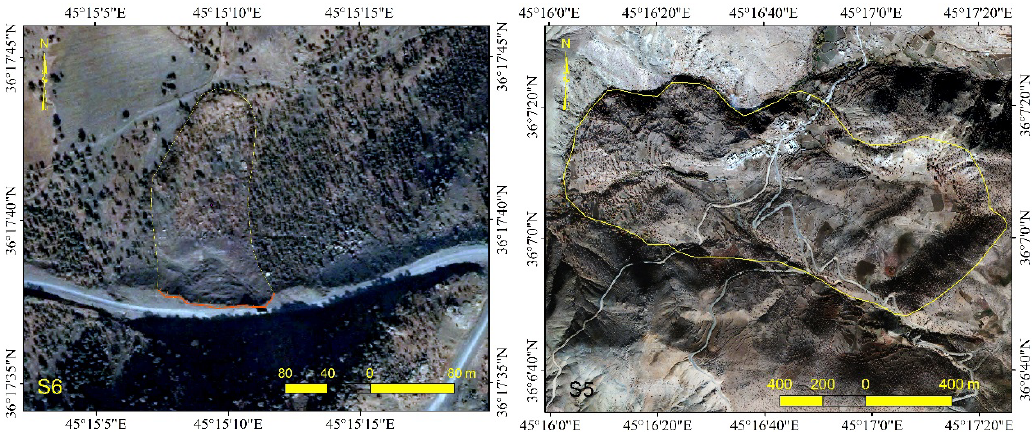
Figure 5. Red, Green, Blue (RGB) 321 of QuickBird data showing examples of detected rotational landslides in the study area. The four images represent the landslides S4, S5, S6 and S9, which were checked in the fieldwork (see Figure